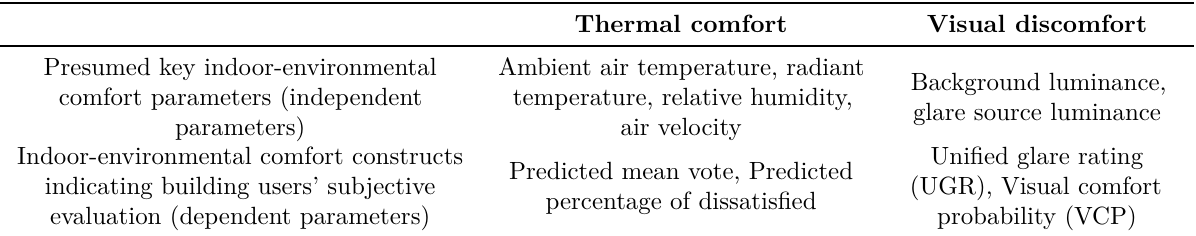
Table 1. Independent and dependent parameters with regard to thermal comfort and visual discomfort.